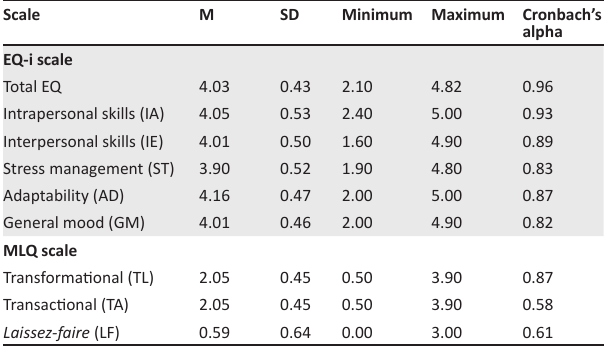
TABLE 2: Descriptive statistics and Cronbach’s alphas for emotional quotient inventory and Multifactor Leadership Questionnaire (Form 5X, Version 2009) ( N =